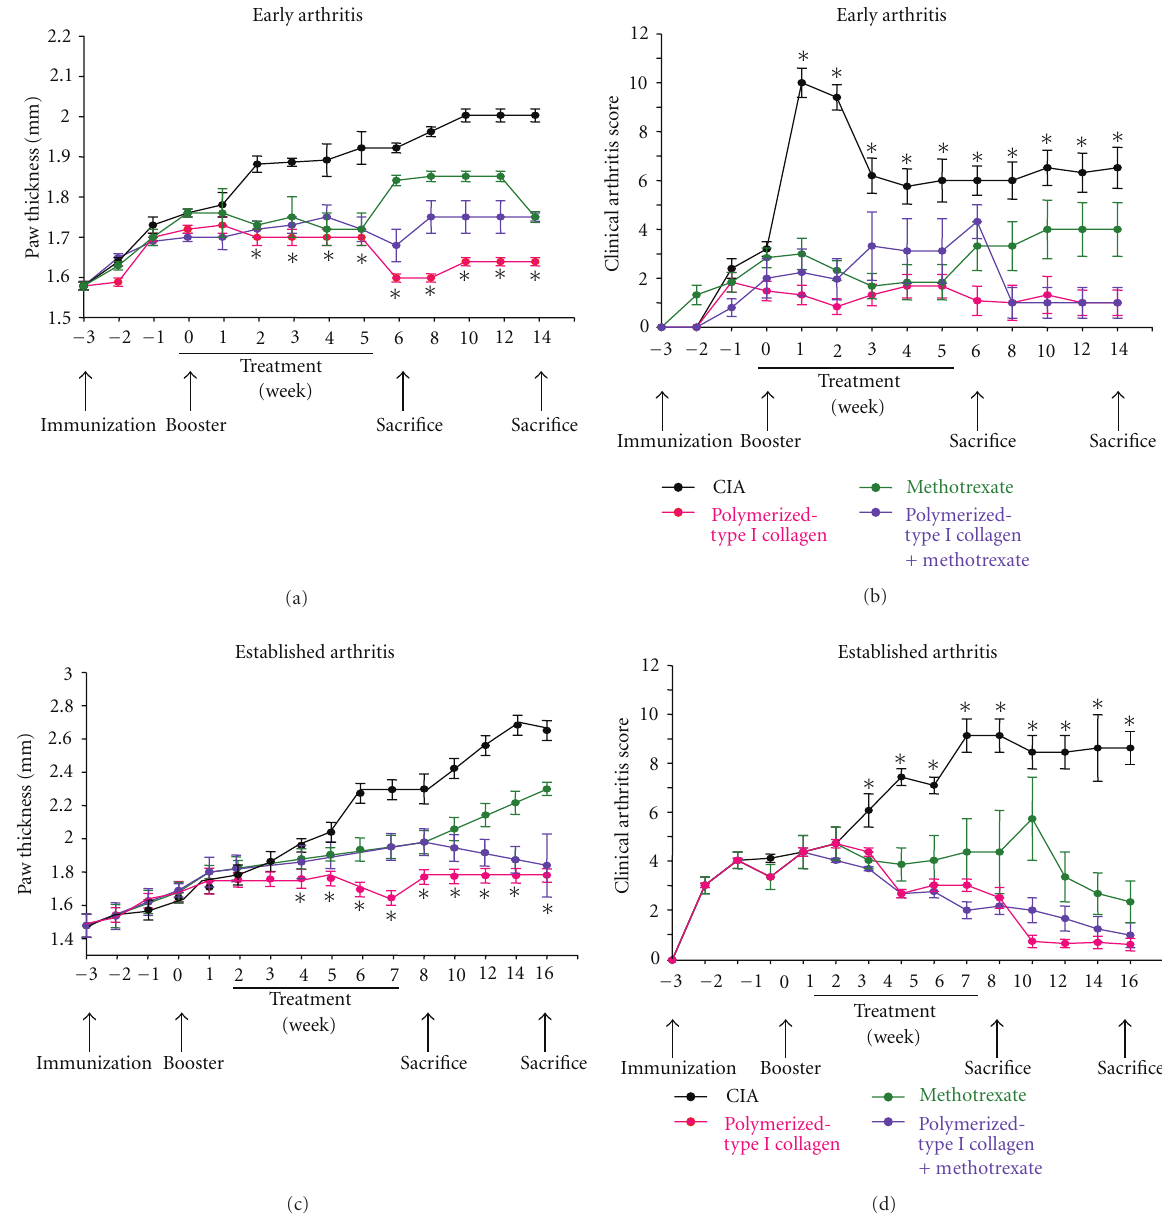
Figure 1: Preventive and therapeutic e ff ects of polymerized-type I collagen on mouse CIA. (a) Paw thickness in early arthritis model. One hundred microliters of Polymerized Collagen, 100 μ L of Polymerized Collagen, and 100 μ L of methotrexate (2.5mg/kg) or 100 μ L of methotrexate (2.5mg/kg)/Polymerized Collagen were administered intramuscular once a week during 6weeks at the same time of that of the booster. Citric/citrate bu ff er was injected as a vehicle control. Data represent mean ± SEM (each group, n = 6). (b) Clinical arthritis score in early arthritis model ( n = 6). (c) Paw thickness in established arthritis model. One hundred microliters of Polymerized Collagen, 100 μ L of Polymerized Collagen, and 100 μ L of methotrexate (2.5 mg/kg) or 100 μ L of methotrexate (2.5mg/kg)/Polymerized Collagen were administered intramuscularly once a week during 6 weeks. Treatments were started on 14 days after the booster. Citric/citrate bu ff er was injected as a vehicle control. Data represent mean ± SEM (each group, n = 6). (d) Clinical arthritis score in established arthritis model ( n = 6). ∗ P < 0 .